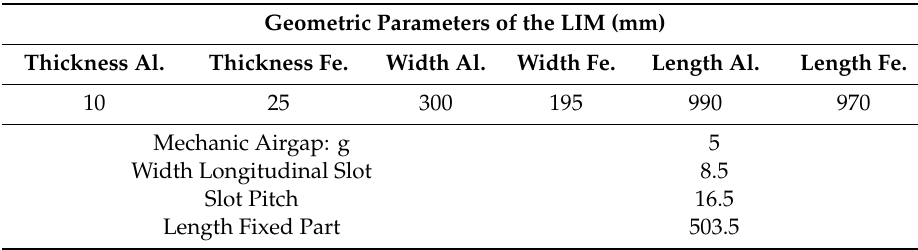
Table 1. Main geometric parameters of the